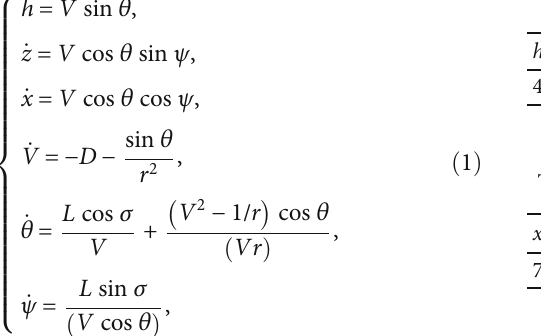
Table 1: Fast trajectories generate initial conditions.